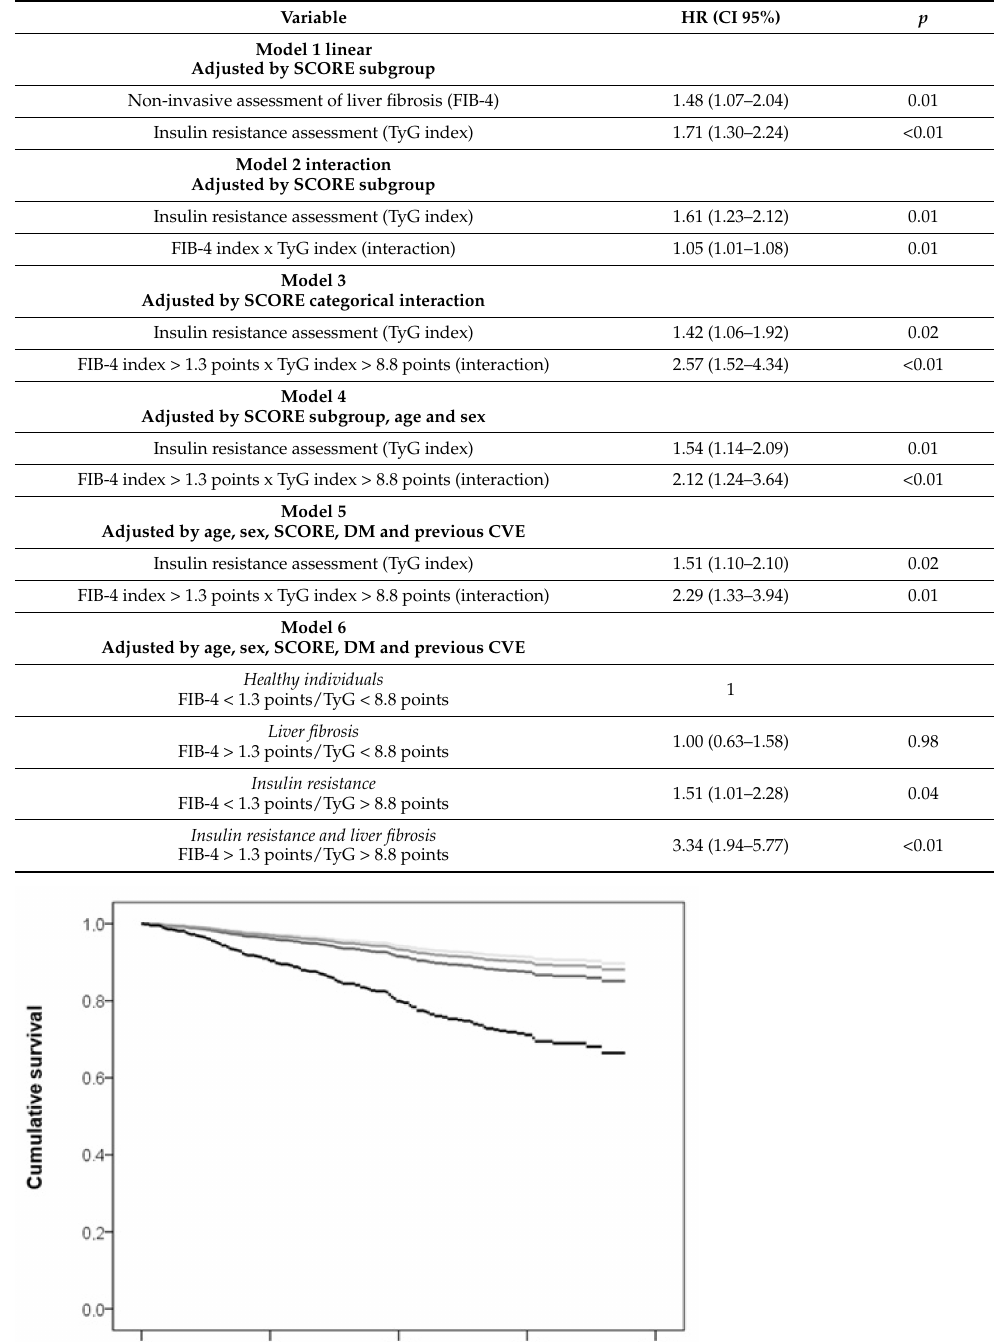
Table 3. Multivariate analysis of the association between insulin resistance and non-invasive liver fibrosis assessment in the prediction of MACE.